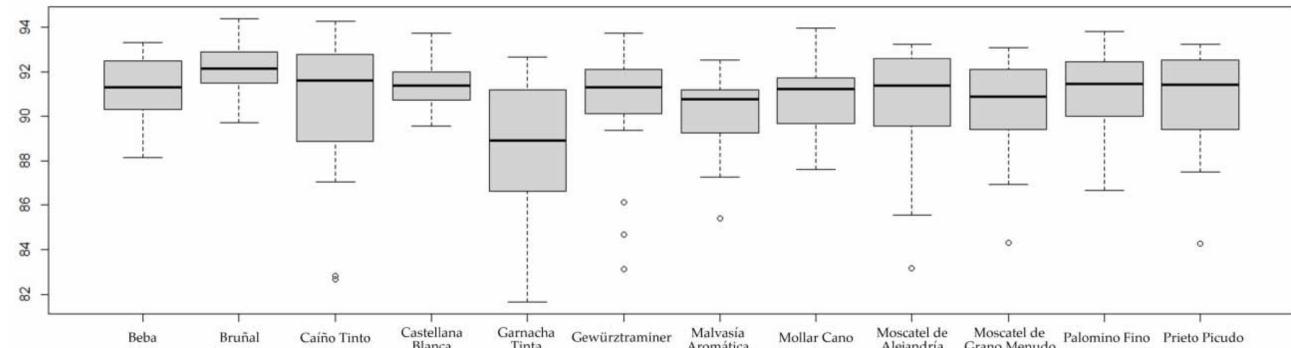
Figure 13. Box-plot representations showing the distribution of J index values in cultivars Beba, Bruñal, Ca í ño Tinto, Castellana Blanca, Garnacha Tinta, Gewürztraminer, Malvas í a Arom á tica, Mollar Cano, Moscatel de Alejandr í a, Moscatel de Grano Menudo, Palomino Fino, Prieto Picudo with the Moscatel